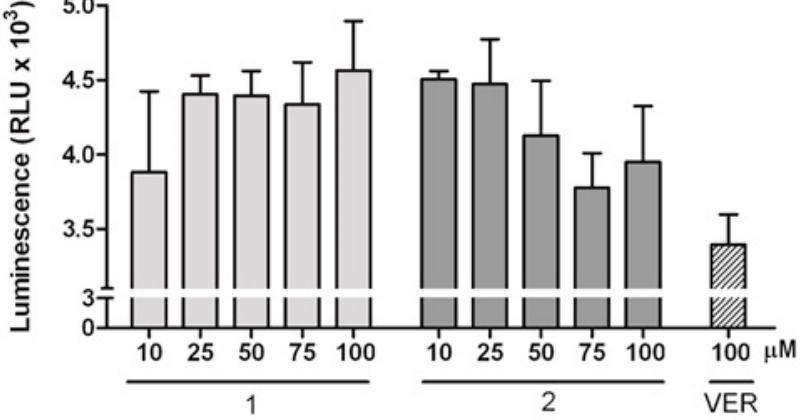
Figure 6. Effects of 1 or 2 and verapamil (VER) on P-gp activity. P-gp ATPase activity was determined by using the P-gp-Glo TM assay system, and ATP accumulation was measured as luminescence in a cellular system in the absence and in the presence of 100 µM verapamil (used as positive control for ATPase activity inhibition) or 1 or 2 at increasing concentrations (10, 25, 50, 75, or 100 µM).